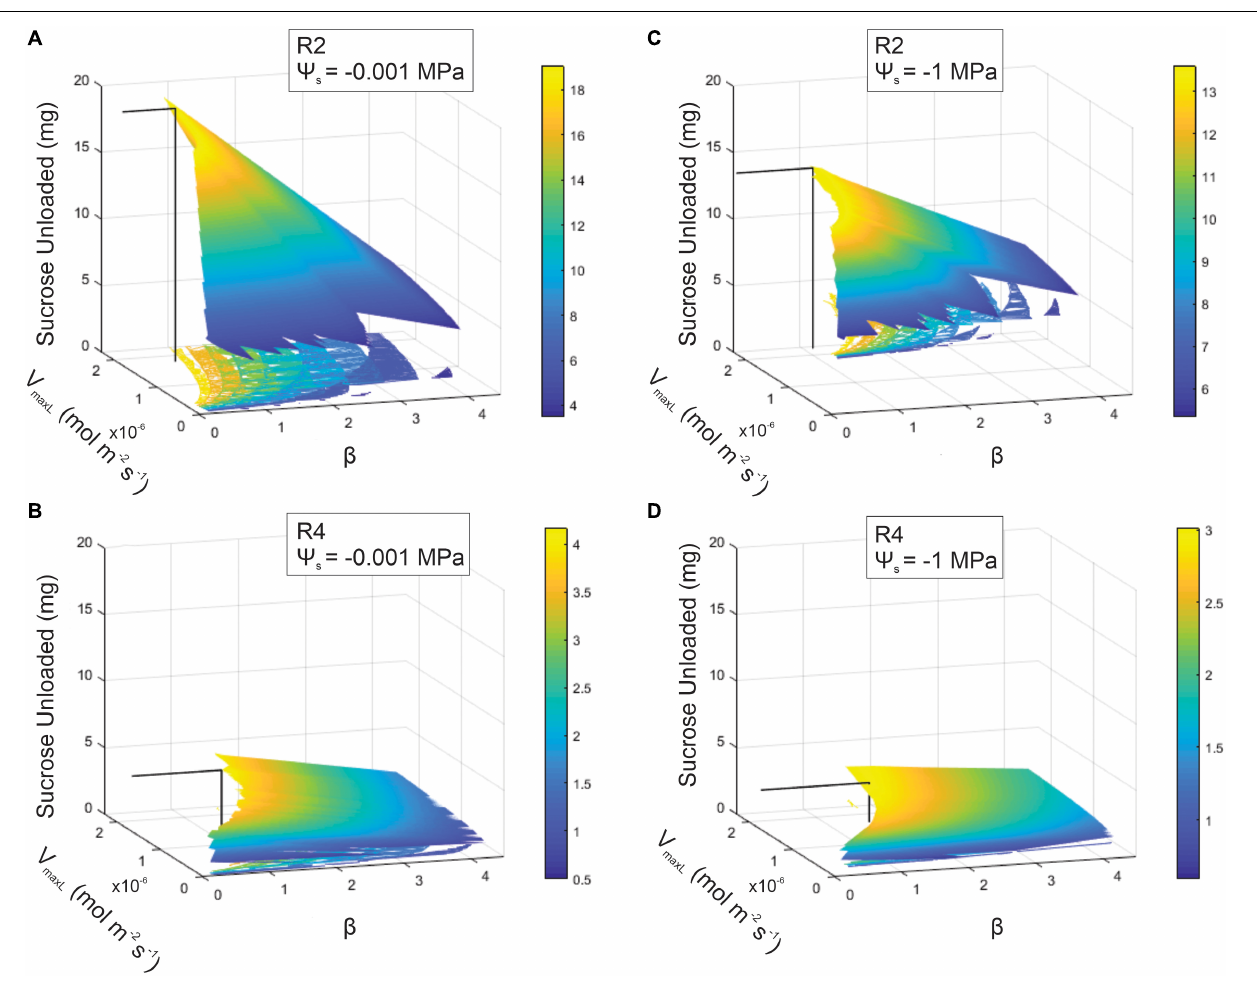
FIGURE 7 | Sucrose output as a function of loading downregulation ( β ) and the maximum rate of sucrose loading (V maxL ) over differing soil water potentials ( (cid:57) s = –0.001 or –1 MPa) or phloem structural resistances ( Rp : R2 or R4). A range of V maxL values were selected from Arabidopsis (1.30e − 8 mol m − 2 s − 1 ) to wheat (2.3e − 6 mol m − 2 s − 1 ). Sucrose output for: (A) R2 and wet soils (maximum sucrose output = 19.07 mg), (B) R4 and wet soils (maximum sucrose output = 4.18 mg), (C) R2 and dry soils (maximum sucrose output = 13.6 mg), and (D) R4 and dry soils (maximum sucrose output = 2.98 mg). The solid black line within each 3D space specifies the maximum sucrose output at a particular V maxL and β